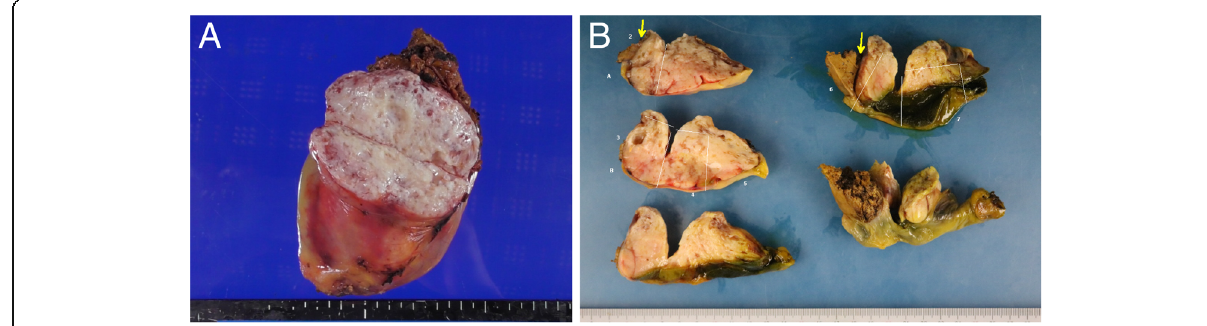
Fig. 5 The resected specimen included a soft, clear-bordered white tumor between the liver tissue and gallbladder that originated from sub- serosal layer of the gallbladder ( a , b